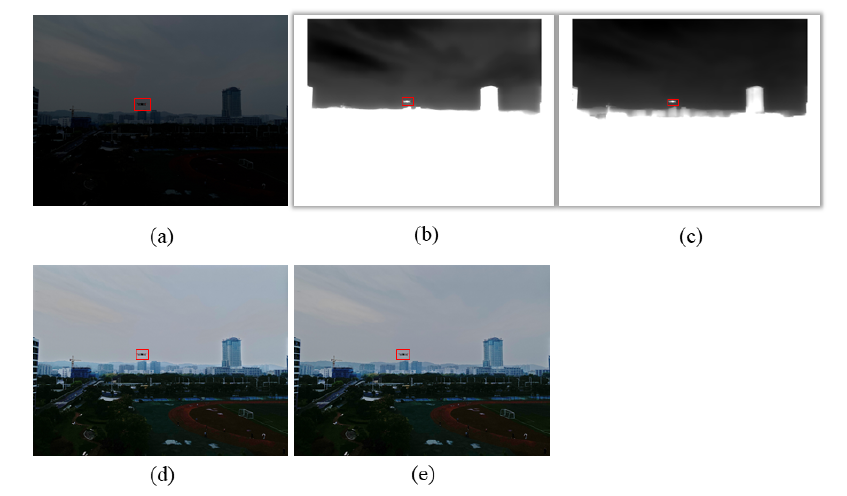
Figure 3. Calculation of exposure ratio matrix.